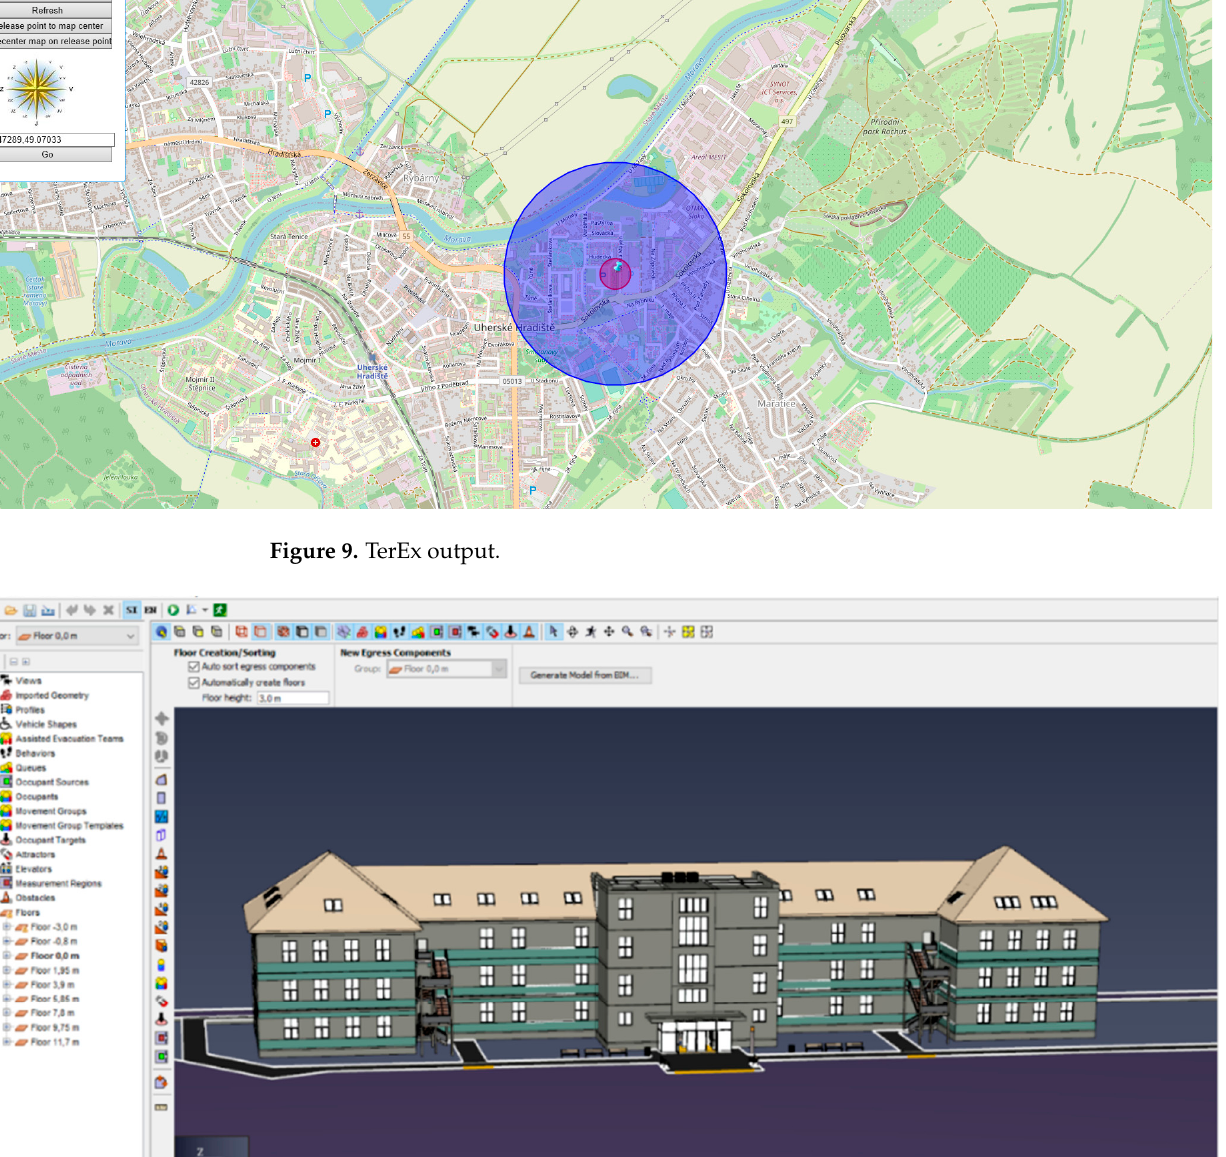
8 of 17 Figure 8. Information about shock wave overpressure. Explanatory notes to Figure 8: •